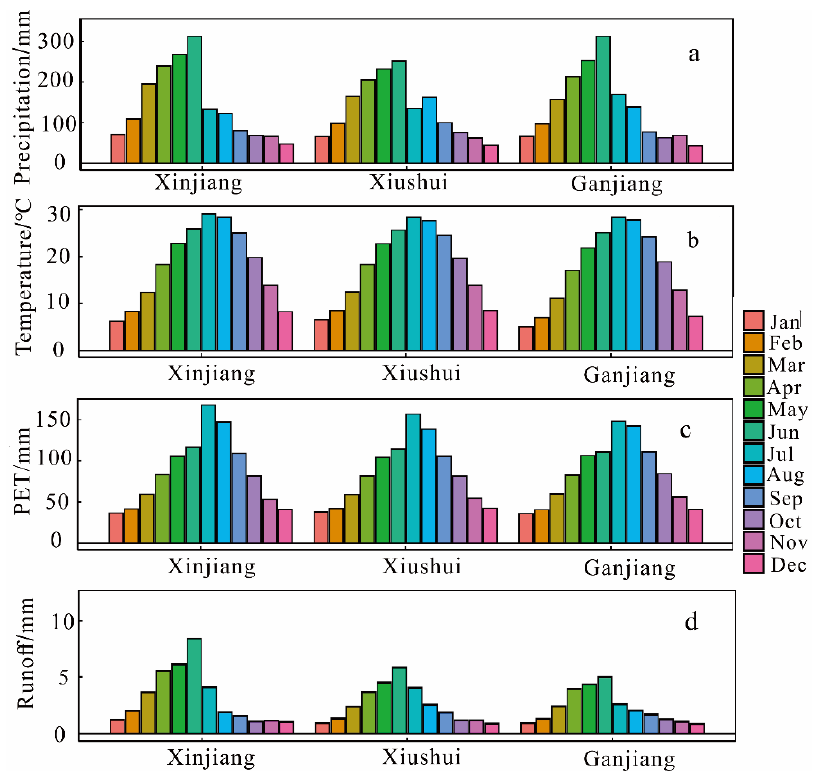
Figure 4. Monthly variations in precipitation, temperature, potential evapotranspiration, and runoff in the Poyang Lake Basin( a : monthly precipitation; b : monthly temperature; c : monthly potential evapotranspiration; d : monthly runoff).